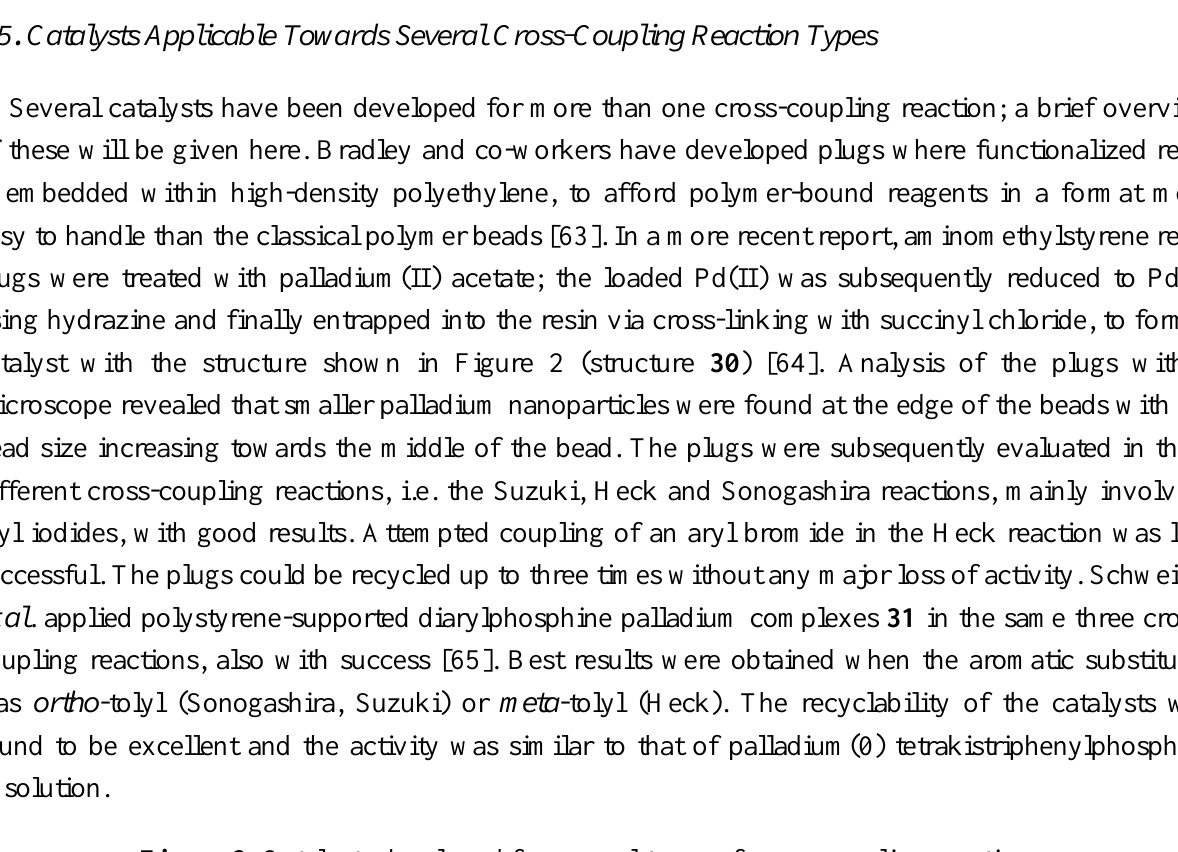
Figure 2. Catalysts developed for several types of cross-coupling